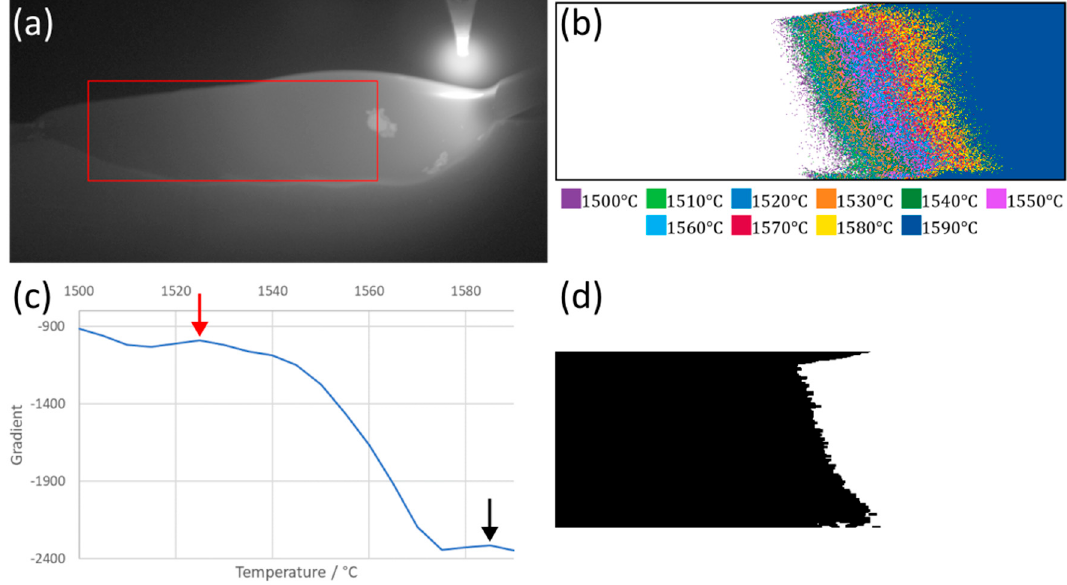
Figure 3. Progression of the analysis for a single still frame. A video of this analysis can be seen in supplementary video S1. ( a ) A still thermal image frame with the cropped region highlighted in red. ( b ) The multiple thresholded cropped regions. Each temperature range represented by a different color for visual clarity (performed every 5 °C, shown every 10 °C). ( c ) The gradient of the area in pixels of the binned images with peaks of the gradient highlighted with arrows. ( d ) The mask produced by taking the highlighted point in red from ( c ). The black region is solid material, and the white represents molten material.